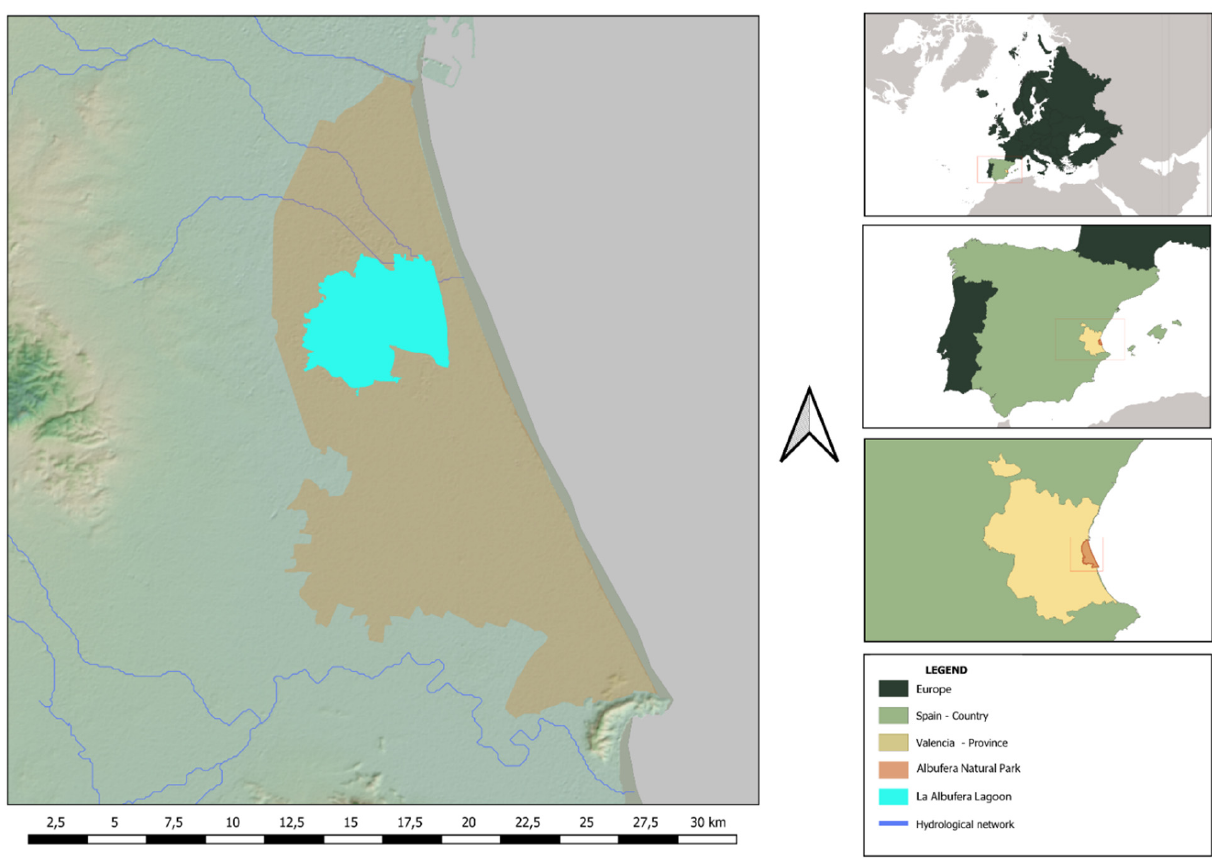
Figure 1. Geographic location of Albufera Natural Park. Source: National Center for Geographic Information (2020).